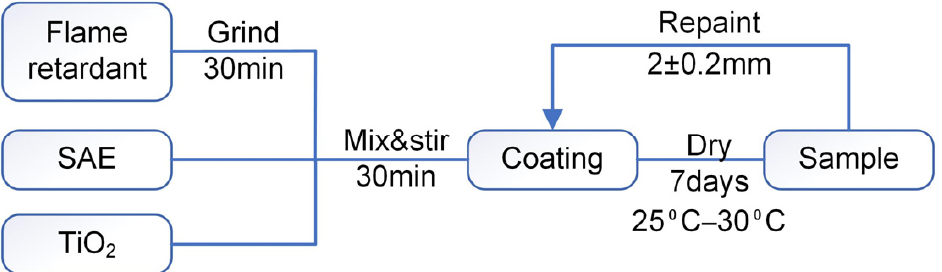
Figure 1. Flow chart of coating preparation.